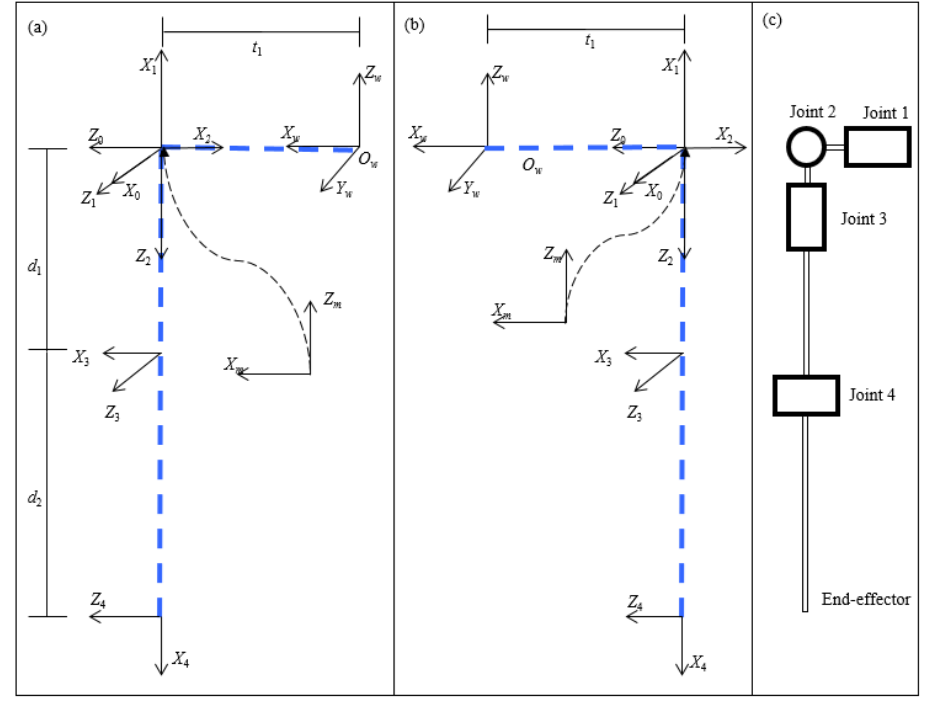
Figure A1. The D-H convention of the Tangy robot: ( a ) right arm; ( b ) left arm; ( c ) the joints and linkages diagram of the Tangy robot arm.